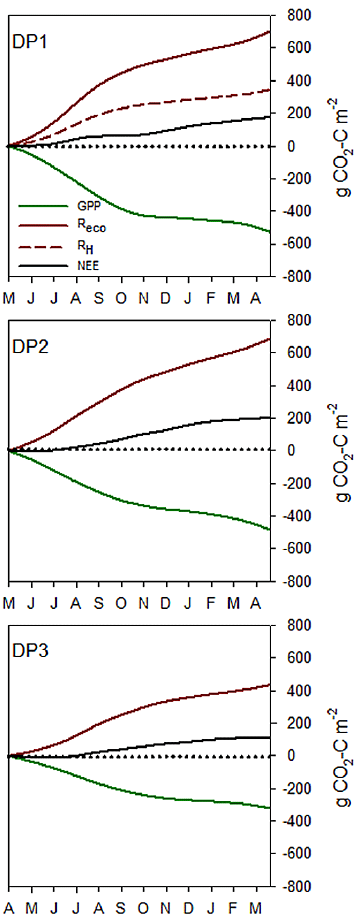
Figure 5. Annual cumulative gross primary productivity (GPP:gCO 2 -Cm − 2 ) , ecosystem respiration ( R eco :gCO 2 -Cm − 2 ) , heterotrophic respiration ( R H : site DP1 only) and net ecosystem exchange (NEE:gCO 2 -Cm − 2 ) at sites DP1–3. Positive values indicate CO 2 -C flux from the peatland to the atmosphere (source) and negative values indicate CO 2 -C flux from the atmosphere to the peatland (sink). Value at end of the curve indicates the total annual value for each component. Note the differences in integration period between sites ( x axis).